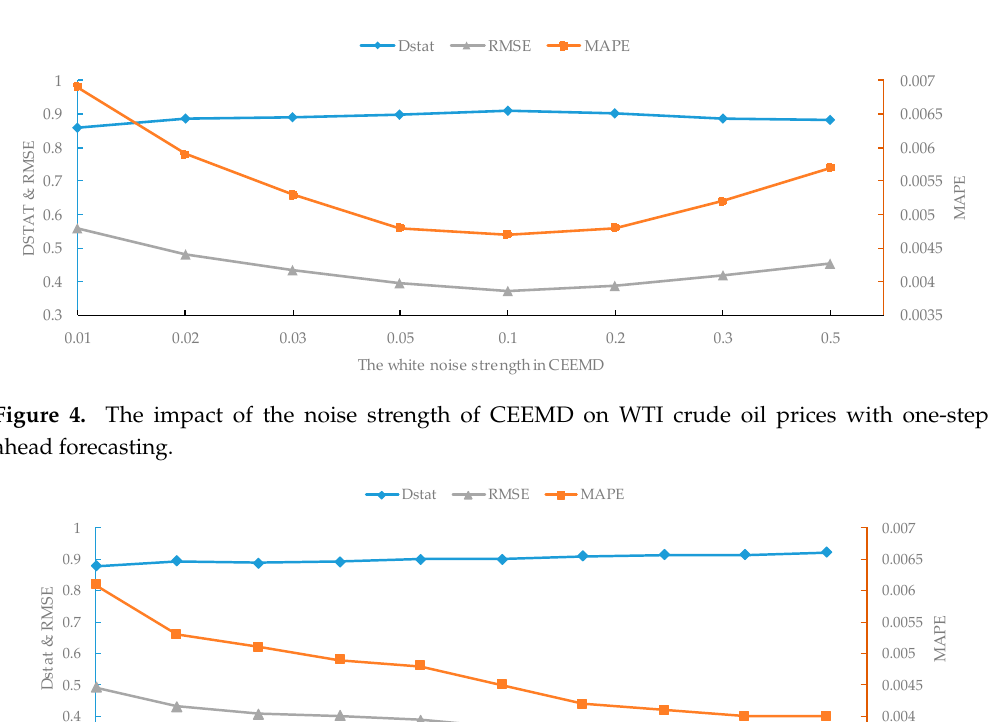
Figure 5. The impact of the number of realizations of CEEMD on WTI crude oil prices with one-step- ahead forecasting.